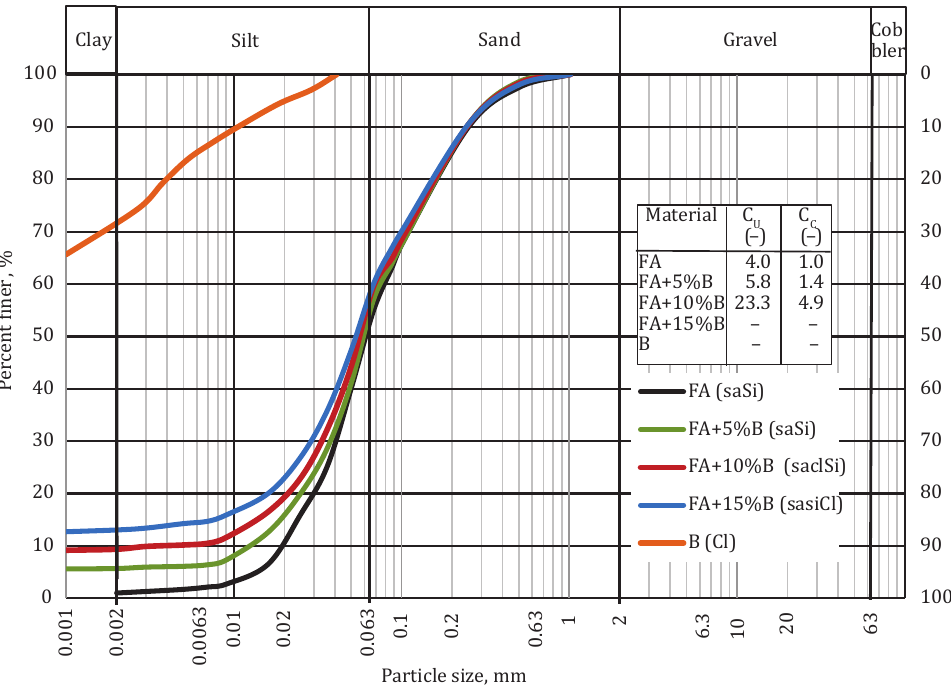
Figure 1. Grain size distribution curves of tested